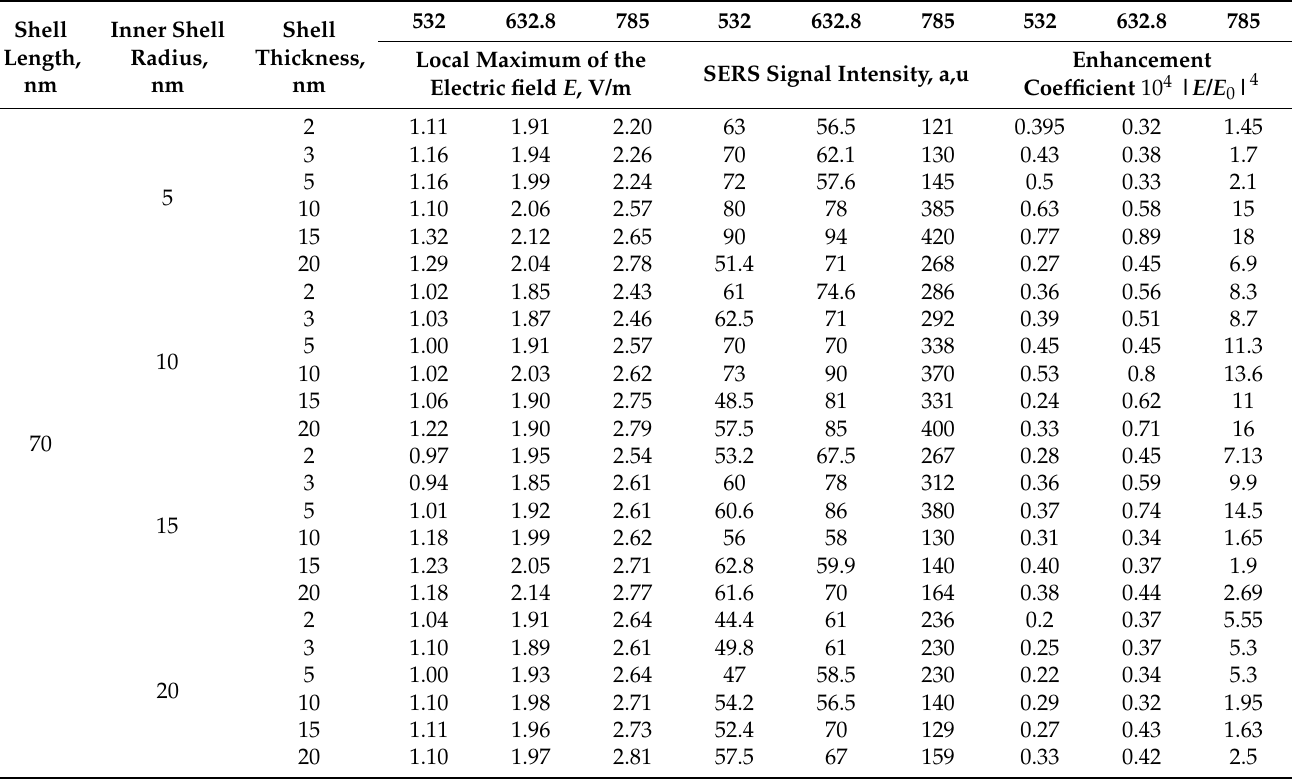
Table 4. Electric field simulation parameters for a SiO 2